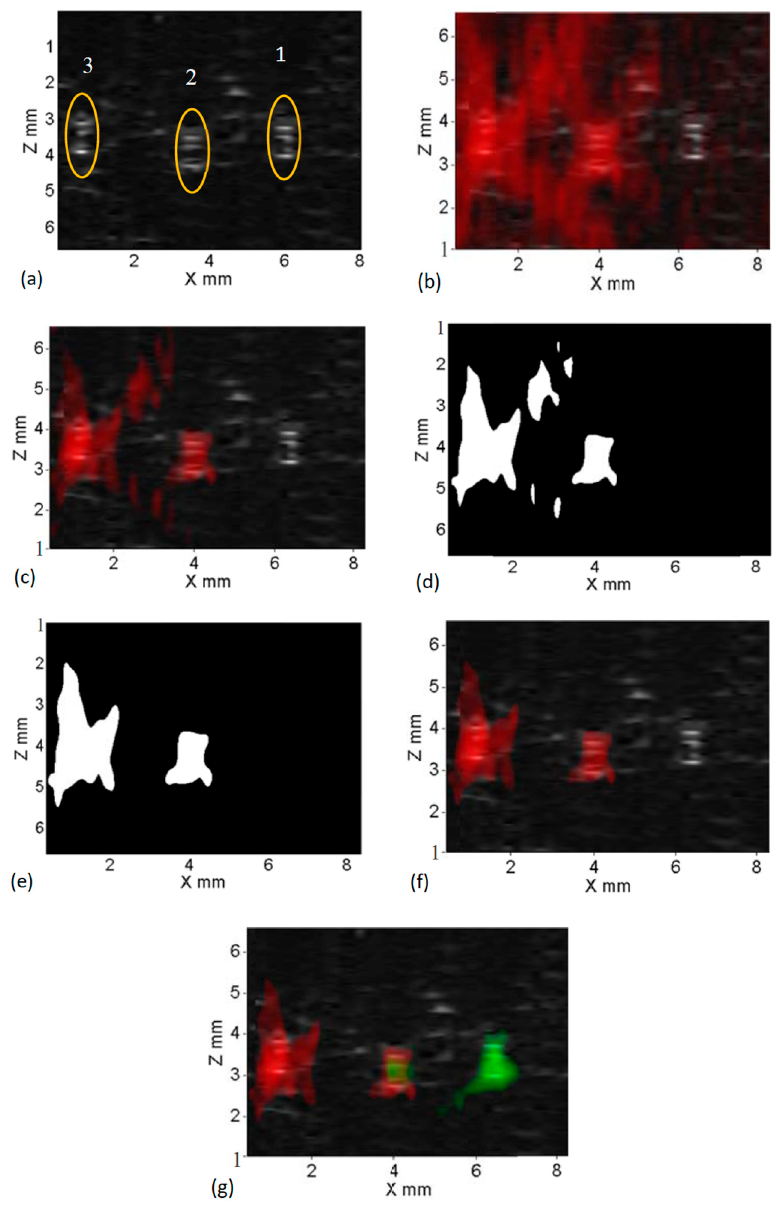
Figure 2. Results obtained using dual-modality imaging system; ( a ) US B-mode image depicting locations of three embedded silicone tubes within a porcine tissue sample; ( b ) USF-ICG image overlaid onto US B-mode image with no threshold applied; ( c ) USF-ICG image overlaid onto US B-mode image with 50% pass through threshold applied; ( d ) binary image obtained by morphological operations; ( e ) final binary image without tail artifacts; ( f ) processed USF-ICG image (using ( e )) overlaid onto US B-mode image; and ( g ) multi-color (red-ICG and green-ADP(OH) 2 contrast agent) multi-modality processed image.